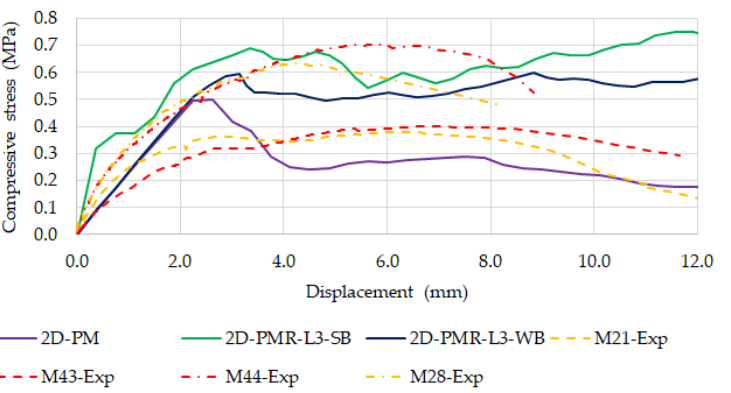
Figure 7. Results of the URM and the reference reinforced (three-level) 2D-PMR models; stress–displacement curves in comparison with the experimental results [2].